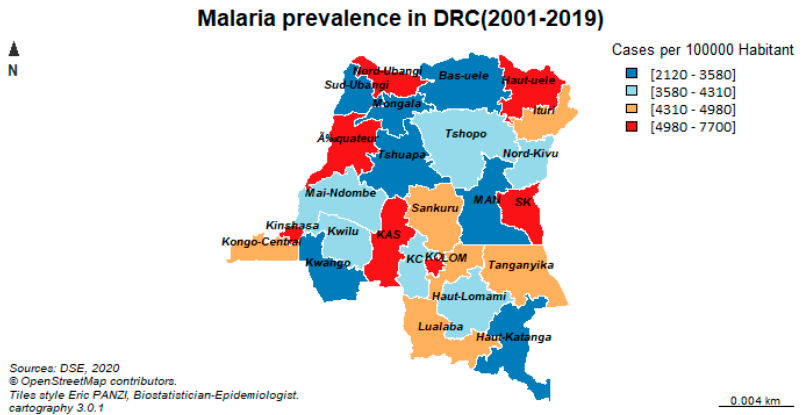
Figure 1. Geographic distribution of malaria prevalence in the DRC from 2001 to 2019.